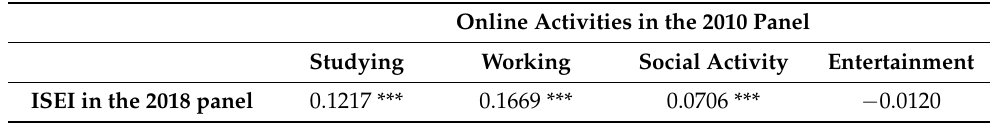
Figure 4. Results of the age cohort from the generalised partial proportional odds model predicting the importance of studying, working, entertainment, and social online activities in the 2010 and 2018 panels. Note: The four panels of studying, entertainment and social activity evaluation included the 1st panel (category 1 versus categories 2, 3, 4, and 5); 2nd panel (categories 1 and 2 versus categories 3, 4, and 5); 3rd panel (categories 1, 2, and 3 versus categories 4 and 5); and 4th panel (categories 1, 2, 3, and 4 versus category 5). Three panels of working activity evaluation included 1st panel (category 1 versus categories 2, 3, and 4); 2nd panel (categories 1 and 2 versus categories 3 and 4); 3rd panel (categories 1, 2, and 3 versus category 4). The detailed data are provided in Supplemental material Table S3. Table 4. Correlation analysis between the importance of the online activities in the 2010 panel and the ISEI scores in the 2018